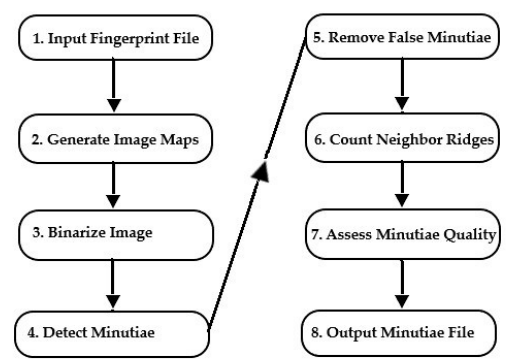
Figure 5. Flow chart for the MINutiae DecTeCTion (MINDTCT) algorithm